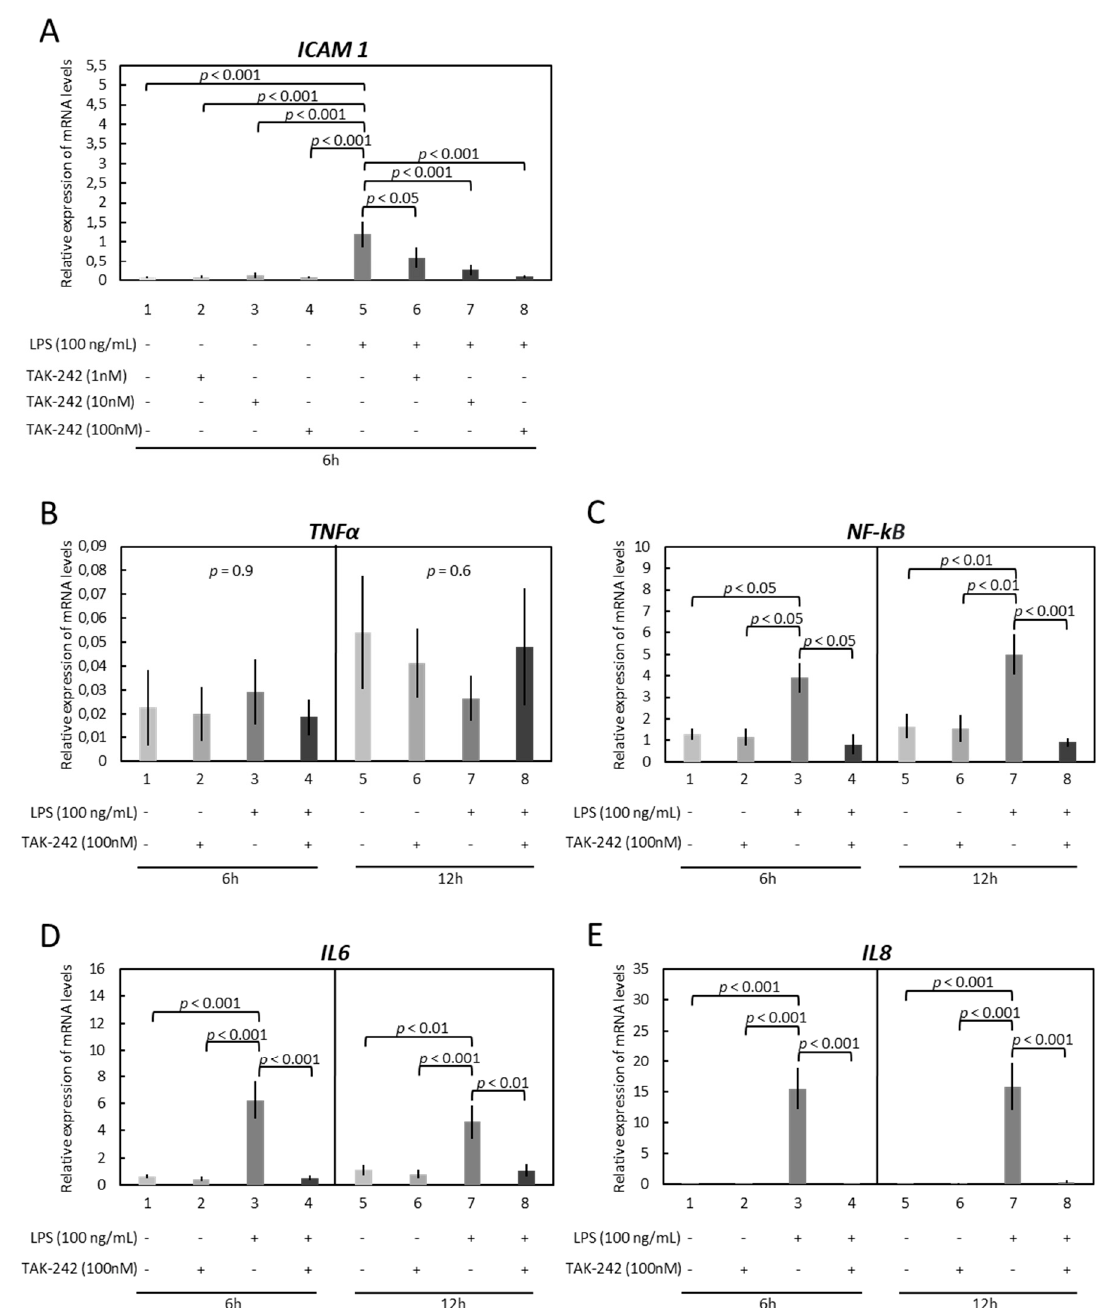
Figure 3. Effects of LPS treatment and functional blocking of TLR4 on expression of ICAM 1 , TNF α , NF-kB , IL6 , and IL8 in immortalized OLENDO cells. Expression of ICAM 1 ( A ), TNF α ( B ), NF-kB ( C ), IL6 ( D ), and IL8 ( E ) as determined by real-time (TaqMan) PCR. A selective blocker of TLR4 (TAK-242) was used as described in the Materials and Methods. A parametric one-way ANOVA was applied followed by the Tukey–Kramer multiple comparisons post-test. All numerical data are presented as the means ± S.D. p -values < 0.05 were considered significant and are